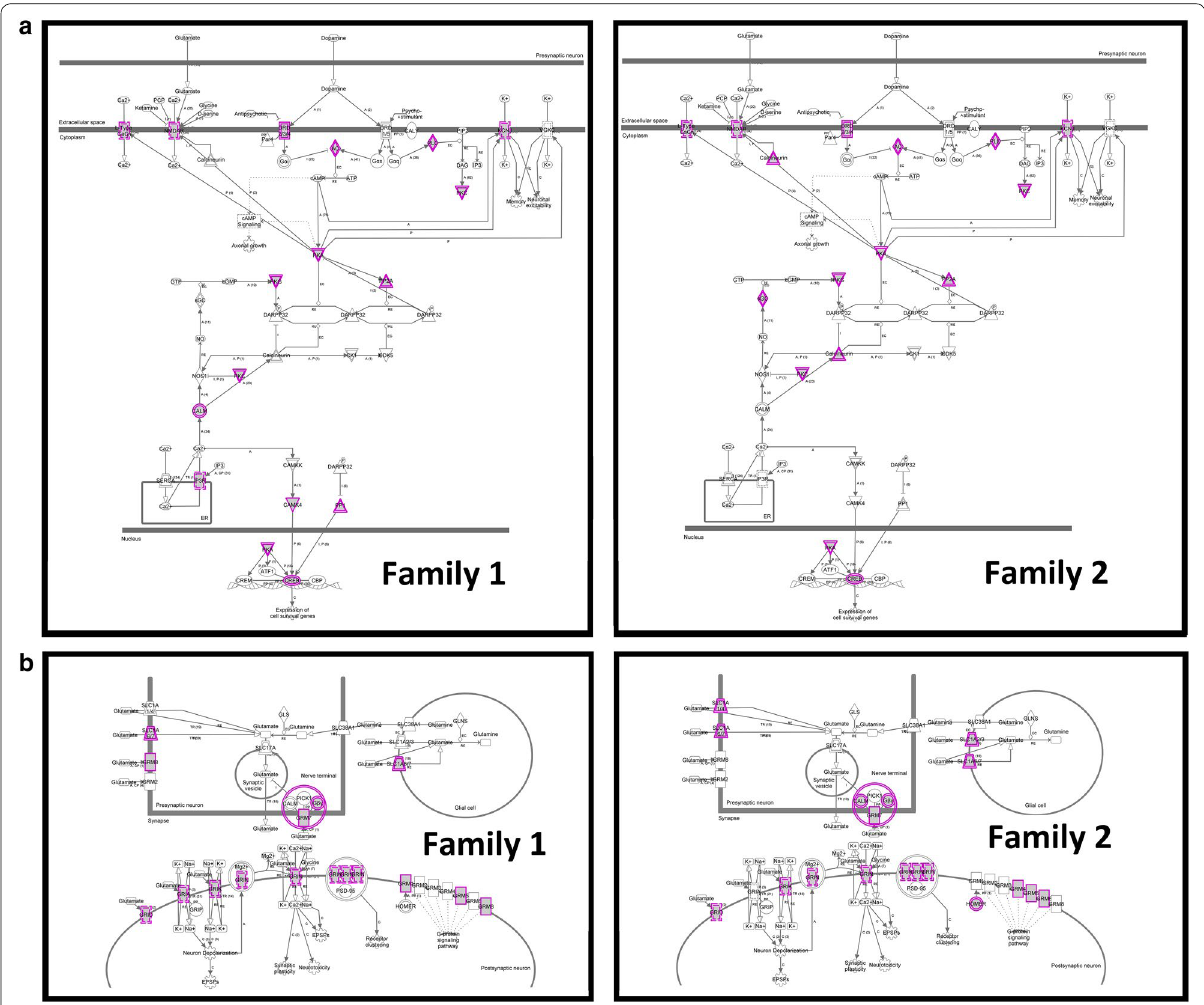
Fig. 7 a Dopamine feedback in cAMP signaling pathway identified using ingenuity pathway analysis (IPA). Genes that were unique to each affected twin were used to generate canonical pathways of interest. This pathway emerged independently in both affected twins. This pathway was also not found to be enriched in unaffected twins in the study. Purple represents genes harboring a unique high confidence variant in each respective patient (family 1, p 2.28E 04; family 2, p 5.84E 03). b Glutamate pathway identified using ingenuity pathway analysis (IPA). Genes that were = − = − unique to each affected twin were used to generate canonical pathways of interest. This pathway emerged independently in both affected